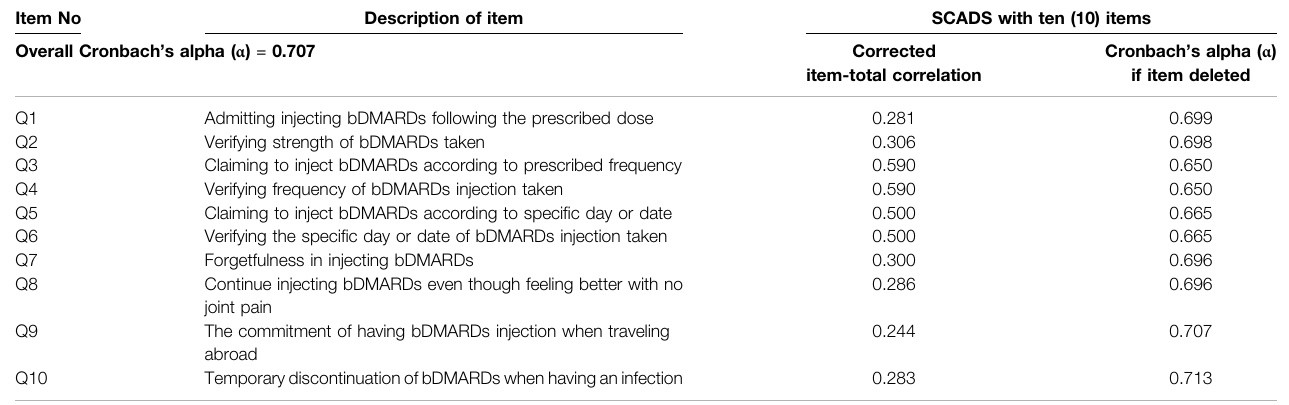
TABLE 3 | Corrected item-total correlation for items in SCADS.